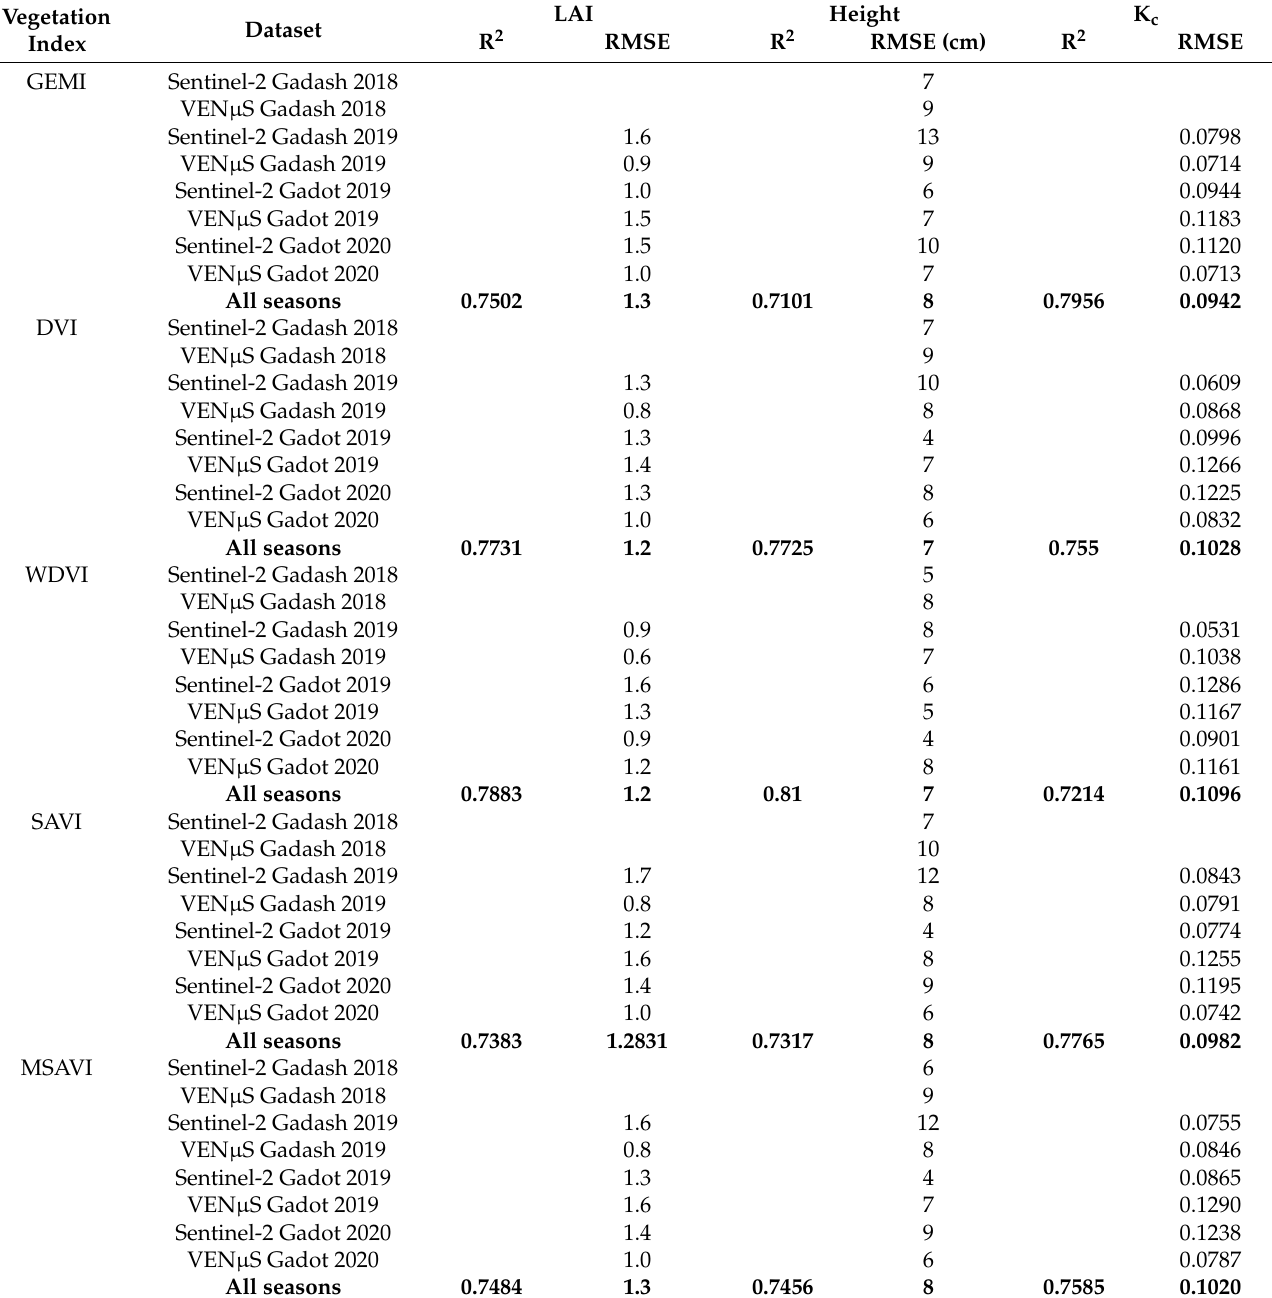
Table 7. Performance statistics of newly developed S2/V T -based LAI, Height, K c models for the best performing VIs. Performance statistics of additional VIs can be found in Appendix